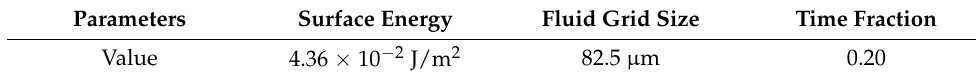
Table 4. Results of parameter calibration of the model.